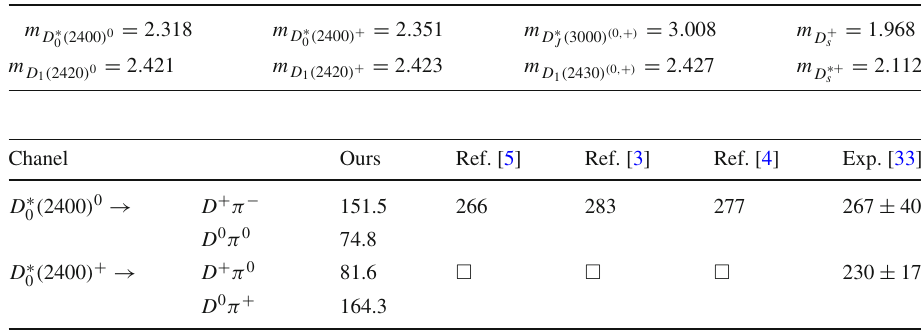
Table 3 Masses of involved